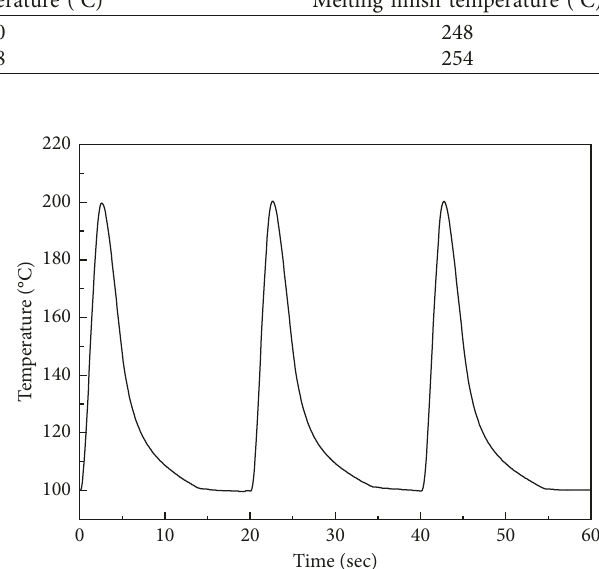
Figure 2: Temperature profile in the power cycling